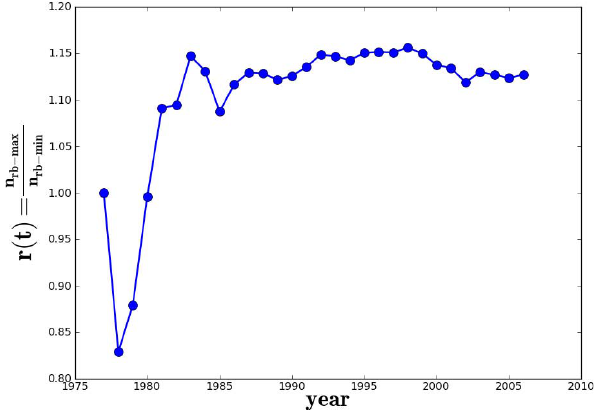
Fig. 7. Values of the ratio r(t) , defined in Eq. (11), from MLO are given as a function of time measured forward from 1977 to 2006.